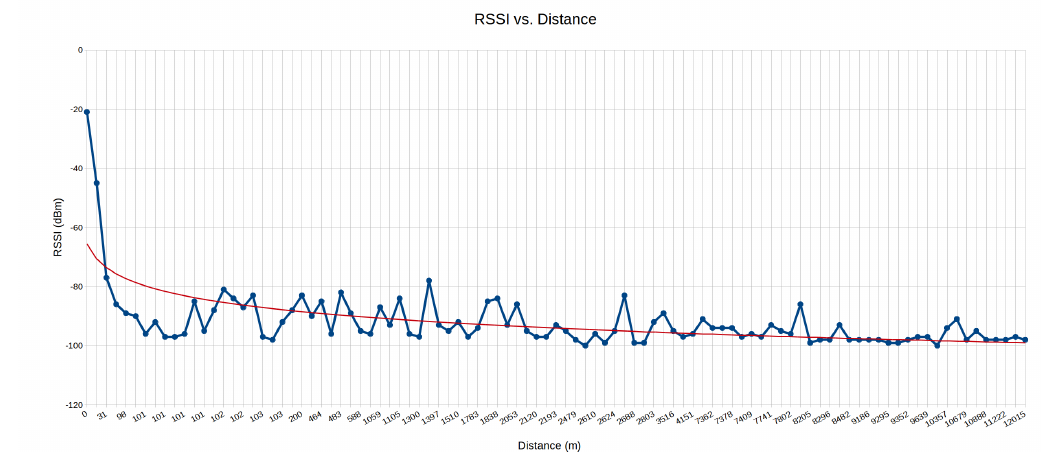
Figure A8. Obtained received signal strength indicator (RSSI) values for experiment in our actual measurement at the Roc’h Trevezel. RSSI values decay as a negative exponential function of distance. The complex terrains in this area seriously impact the quality of radio links.